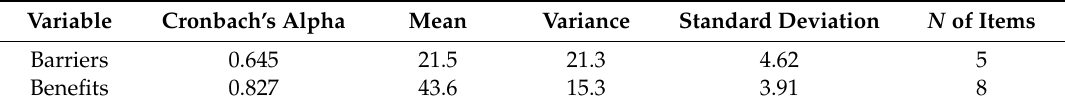
Table 2. Two-factor PCA reliability statistics of benefits and barriers